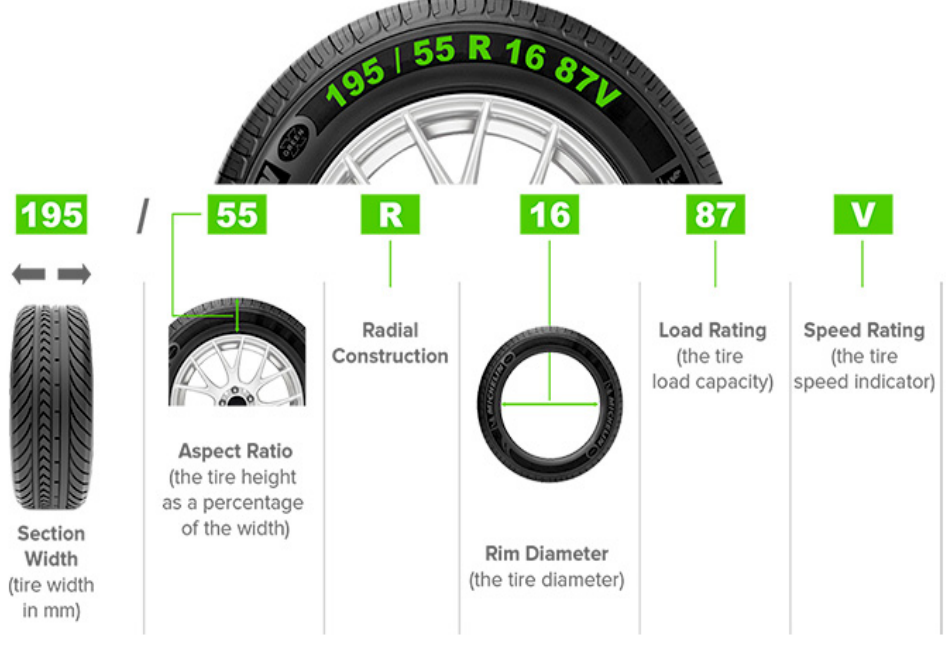
Figure 1. Tyre Figure 1. Tyre specification.